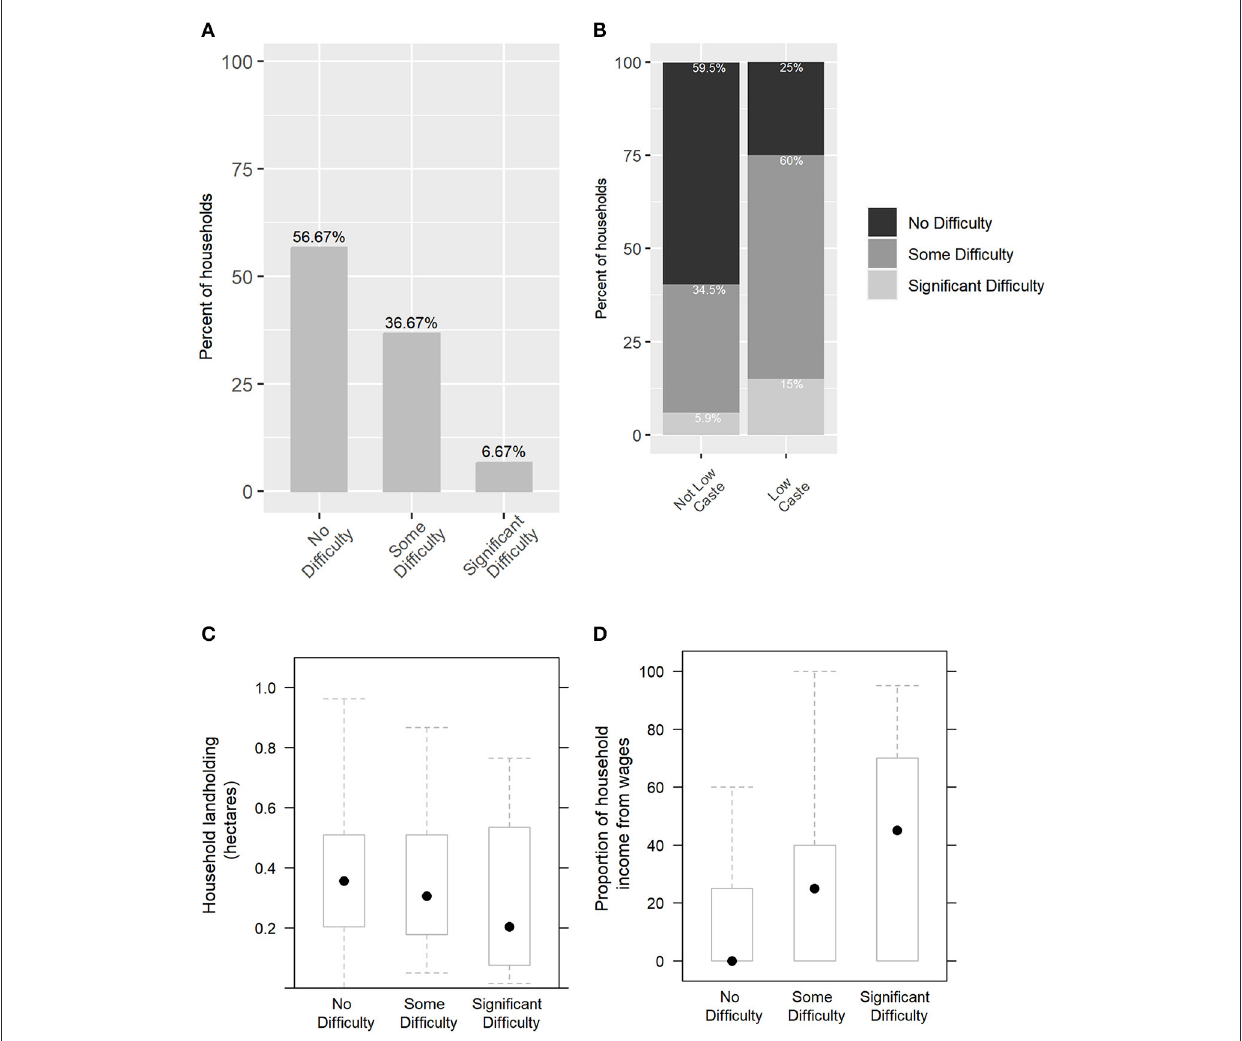
FIGURE2 Experiences of food insecurity. Households reported “no,” “some,” “significant” difficulties in accessing sufficient food in the 2 months following the initial lockdown in 2020: (A) in overall percentage; (B) across caste groups; (C) by proportion of income from wage labor; (D) according to landholding size. General castes in (B) represent higher castes such as Brahmin and Chhetri and